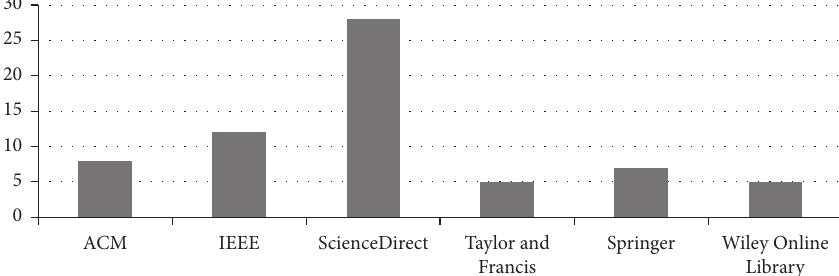
Figure 13: Number of the selected studies in the given libraries.